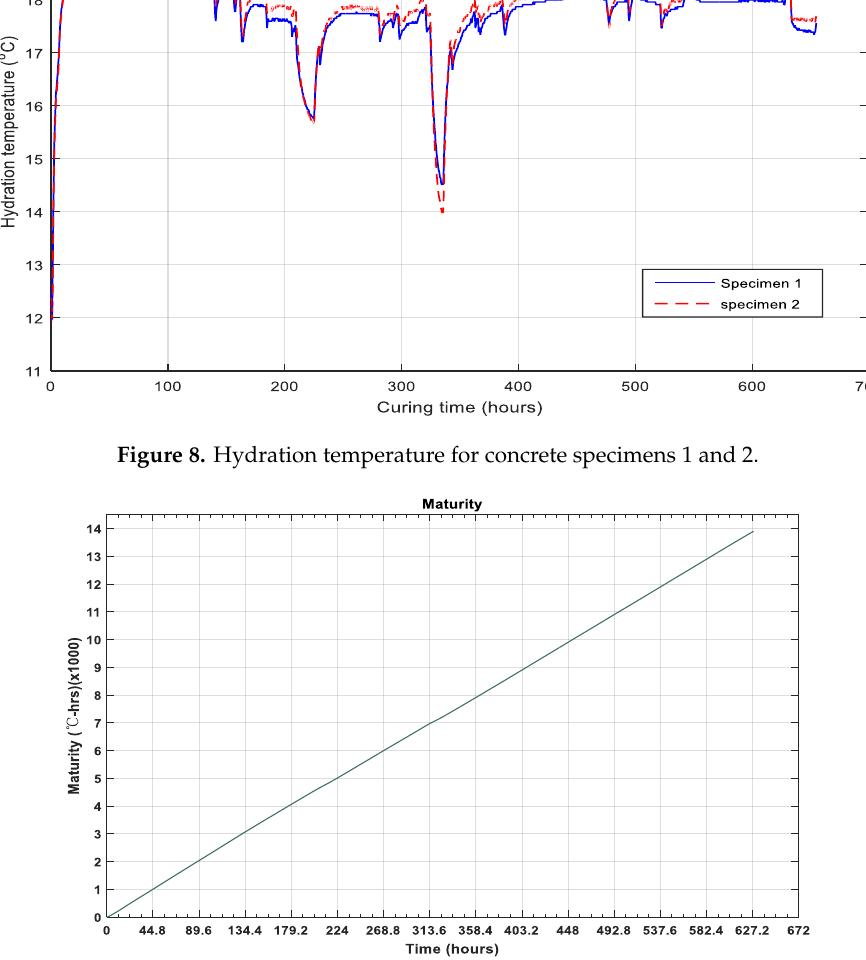
Figure 9. Maturity data for the hydration-temperature monitoring.